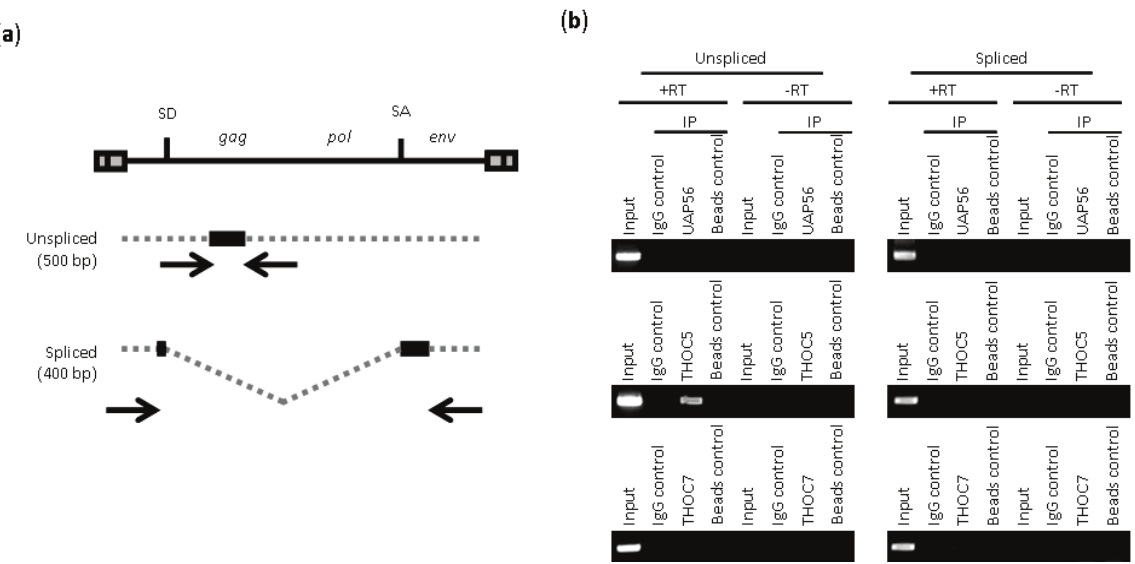
Figure 3. THOC5 interacts with unspliced MLV transcript. ( a ) Schematic representation of MLV genomic RNA and viral mRNAs. Arrows indicate the positions and the orientation of the PCR primers for RIP assay. The black square indicates the expected PCR products with predicted size at the left; ( b ) RIP assay was performed to detect UAP56-, THOC5-, or THOC7-associated viral transcripts. Immunoprecipitation (IP) was conducted in the presence of isotype control (IgG control), UAP56, THOC5, or THOC7 antibodies. IP without any antibodies (Beads control) is also included as a negative control. RT-PCR was performed to detect MLV transcripts in RNA samples isolated from the immunoprecipitates with (+RT) or without ( − RT) reverse transcriptase.